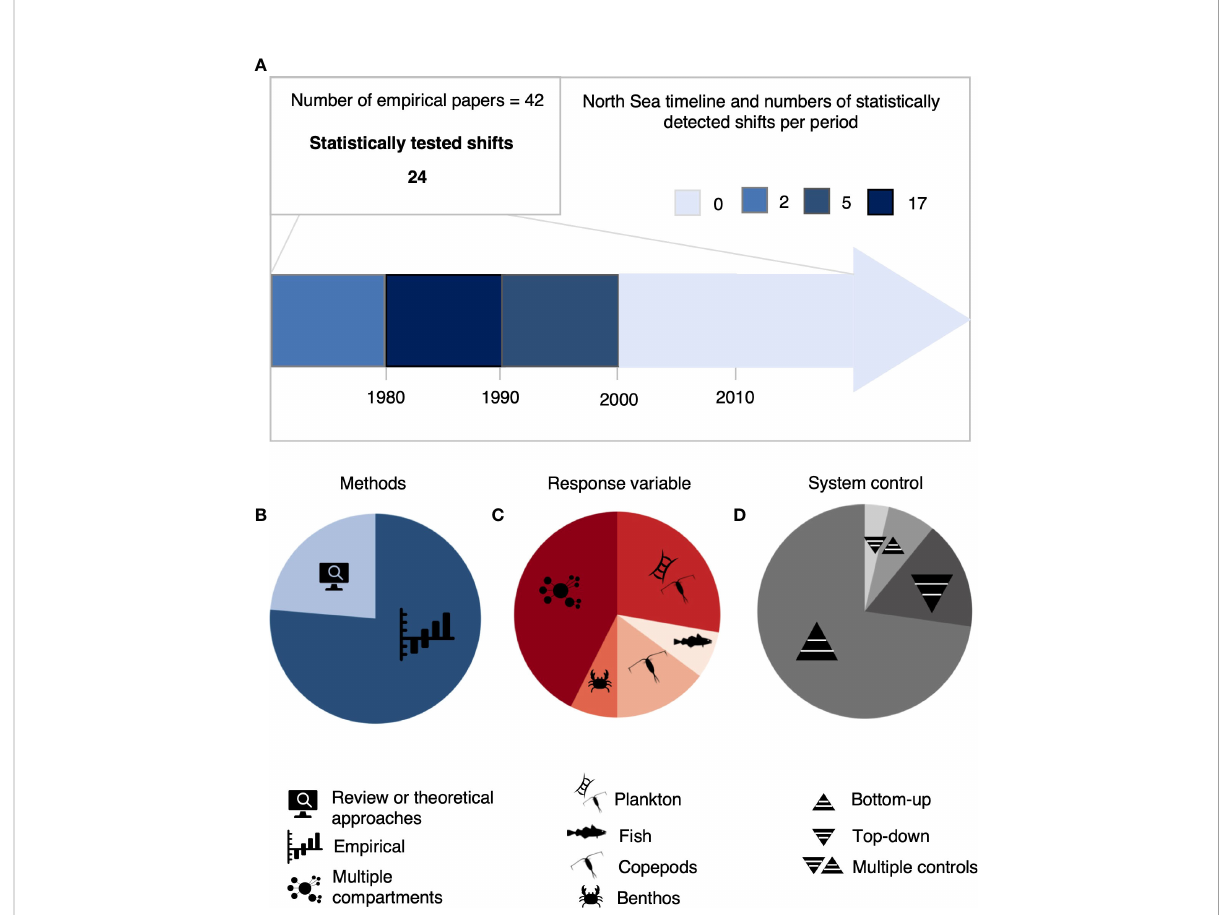
FIGURE 1 Results of the systematic literature review on regime shifts in the North Sea ecosystem. In total 55 papers dealt with regime shifts and 72 shifts were recorded. (A) , Decadal occurrence of reported statistically tested regime shifts. 42 papers used empirical methods but just 24 tested the abrupt shift. (B – D) , Percentage distribution of statistical methods applied, response variable and type of ecosystem control considered in reviewed studies. The percentages were calculated against the total number of papers (i.e.